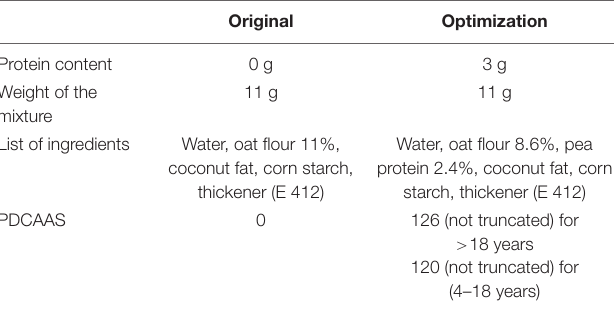
TABLE 7 | Comparison of optimized yogurt analog formula versus original